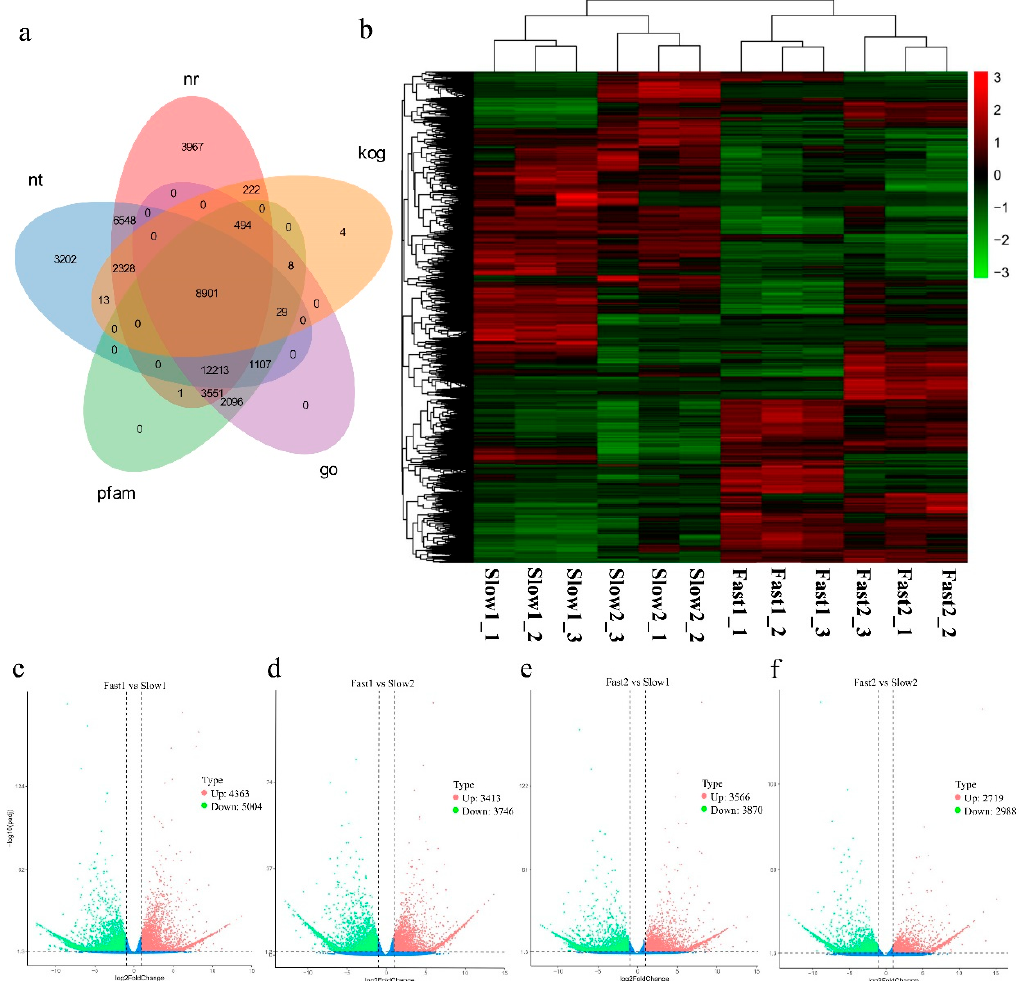
Figure 2. ( a ) Venn diagram of functional annotations of unigenes in nt (NCBI non-redundant protein sequences), nr (NCBI non-redundant protein sequences), kog (Clusters of Orthologous Groups of proteins), go (Gene Ontology) and pfam (Protein family) databases. ( b ) Heatmap of expression patterns in fast- (Fast1: UGu17 and Fast2: UZuantian) and slow-growing cultivars (Slow1: U81-07 and Slow2: U82-39) samples. ( c – f ) Expression patterns of differentially expressed genes (DEGs) identified between fast- and slow-growing cultivars. Red and green dots represent DEGs, blue dots indicate genes that were not differentially expressed. Totals of 9367 (Up = 4363, Down = 5004), 7159 (Up = 3413, Down = 3746), 7436 (Up = 3566, Down = 3870), 5707 (Up = 2719, Down = 2988) unigenes were filtered as dysregulated genes in comparisons between Fast1 vs. Slow1 (F1vS1), Fast1 vs. Slow2 (F1vS2), Fast2 vs. Slow1 (F2vS1), Fast2 vs. Slow2 (F2vS2) with the cutoff of padj < 0.05 and |log2(foldchange)| > 1.